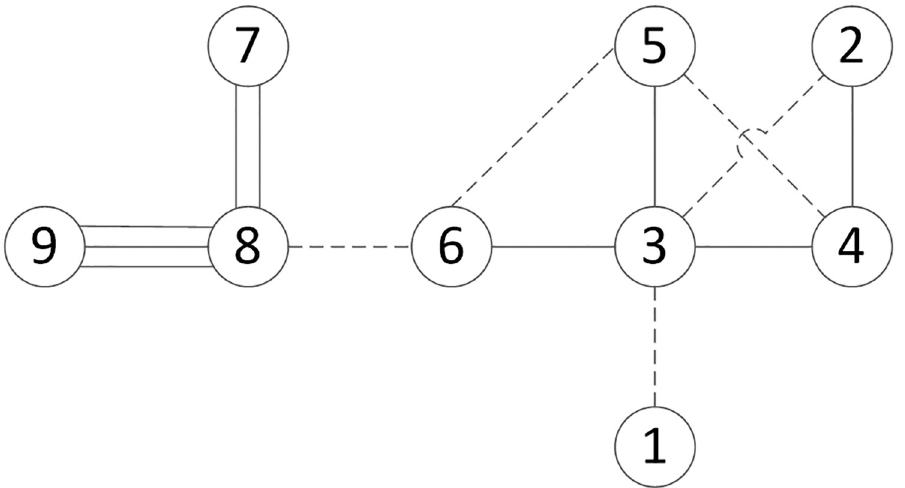
Fig 8. Correlation diagram of production unit location.